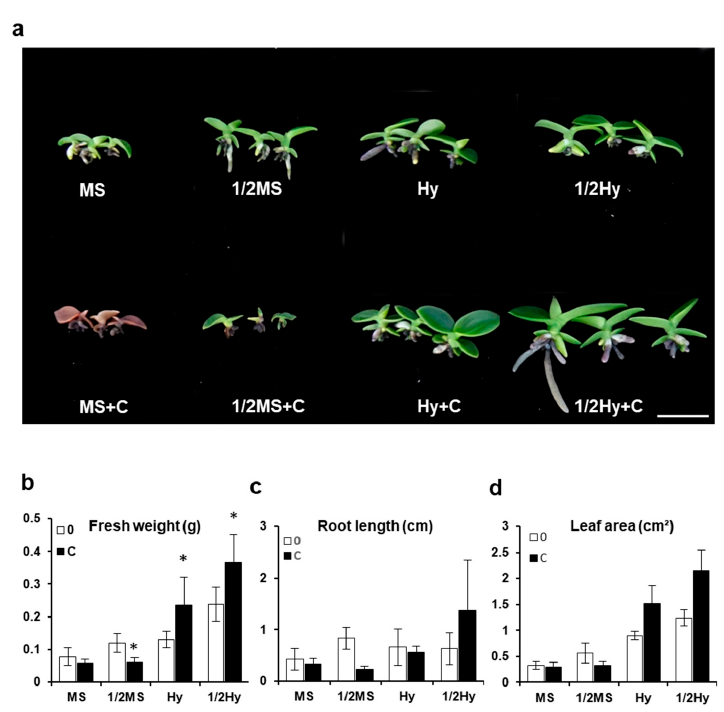
Figure 3. Effect of activated charcoal (AC) on Sedirea japonica seedling growth. ( a ) Growth differ ‐ ences in seedlings were determined seven months after sowing. The pictures show a representa ‐ tive seedling of each medium. Fresh weight ( b ), root length ( c ), and leaf area ( d ) were measured. Scale bar = 2 cm. C: activated charcoal; MS: full ‐ strength MS; 1/2MS: half ‐ strength MS; Hy: full ‐ strength Hyponex; 1/2Hy: half ‐ strength Hyponex. Data are shown as mean ± SD of the values ob ‐ tained from triplicate experiments. * p ≤ 0.05.